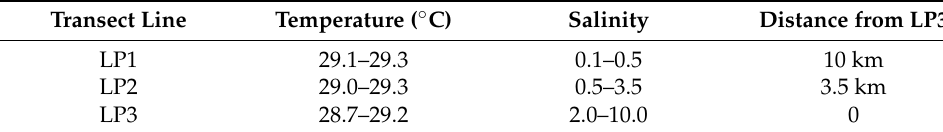
Table 1. Temperature and salinity at survey sites in Perak River.